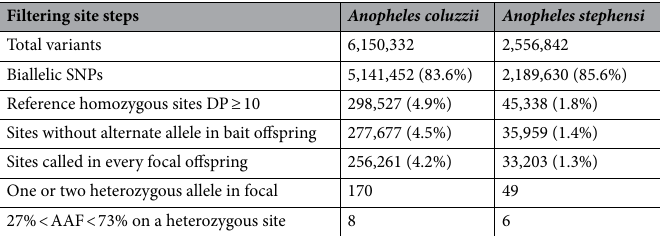
Table 3. Candidate mutation detection summary. The number of sites filtered out at each step of the candidate mutation detection protocol. DP depth, AAF alternate allele frequency.